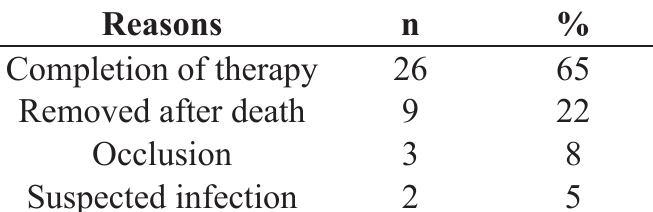
TABLE 4 - Reasons for removal of